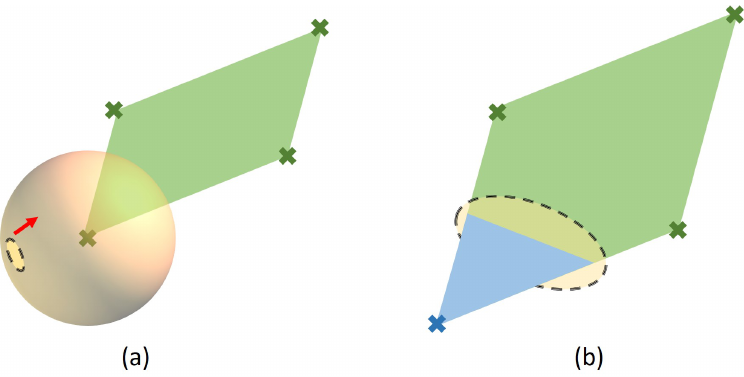
Figure 2: The process of (a) applying the symmetry locally to permute a charge and then removing the domain wall thus created by dragging a twist loop over it cannot result in the twist loop fusing to vacuum, since it results in the configuration shown in (b). Operators acting on the first (second) layer are represented by the green (blue)